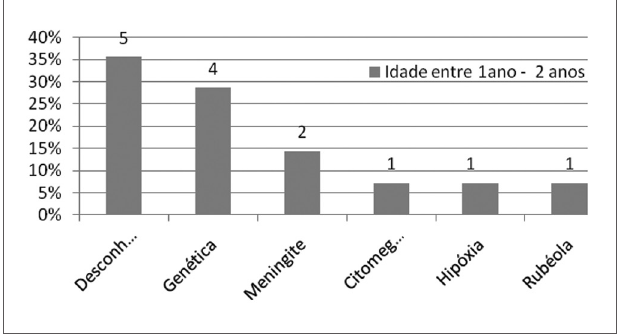
Figura 9. Distribuição etiológica dos pacientes implantados na faixa etária entre 1 ano e 2 anos de